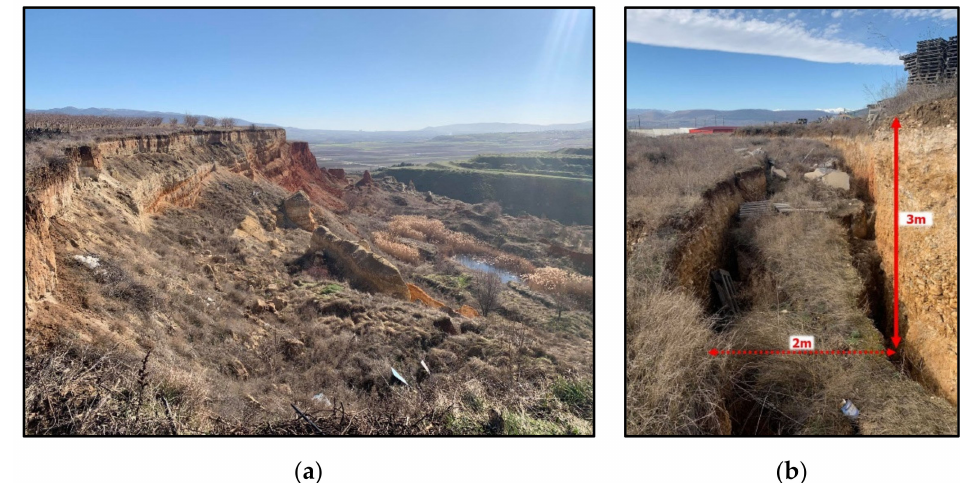
Figure 2. ( a ) Photo taken during the field investigations from the upper part of the scarp; ( b ) photo showcasing the large transversal cracks that occurred due to the retrogressive failure